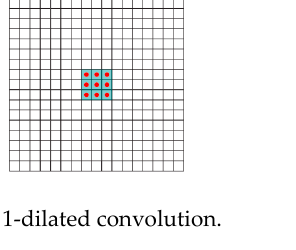
Figure 2. Receptive field size of different dilated convolution. ( d = 1, 2, and 4, where the dark color regions represent the receptive field.).